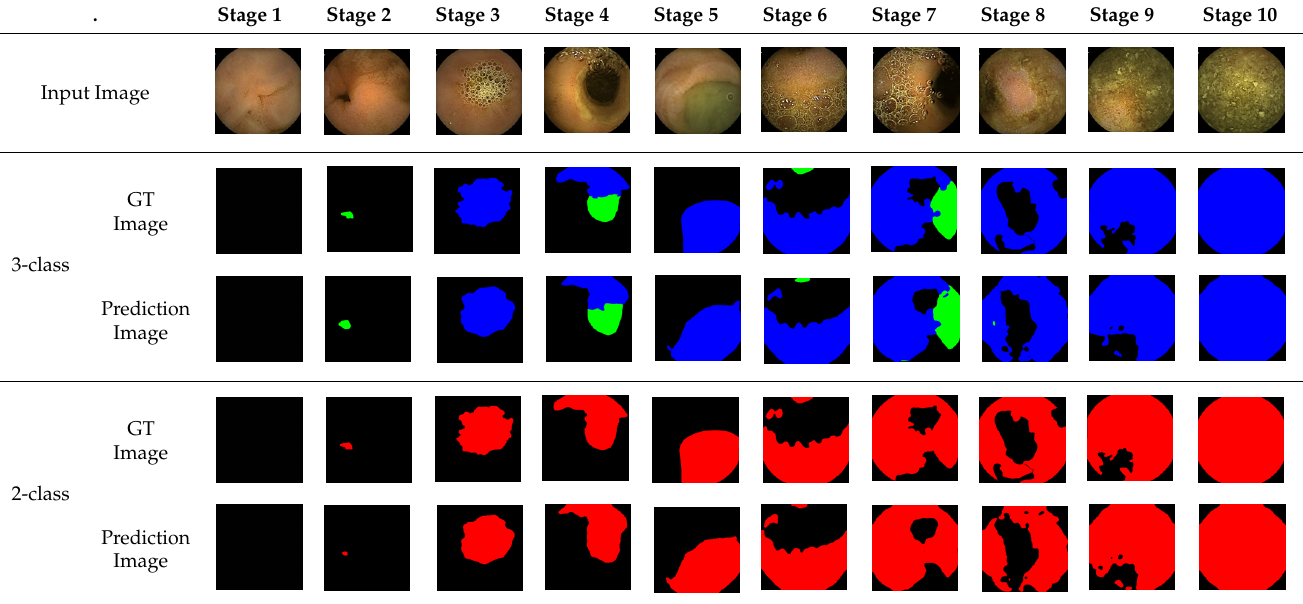
Table 6. Examples of test Patient 5. Input images (first row). Center-cropped images (second row). GT region annotated images and our prediction results for the 3-class case (third and fourth rows) and 2-class case (fifth and bottom rows).